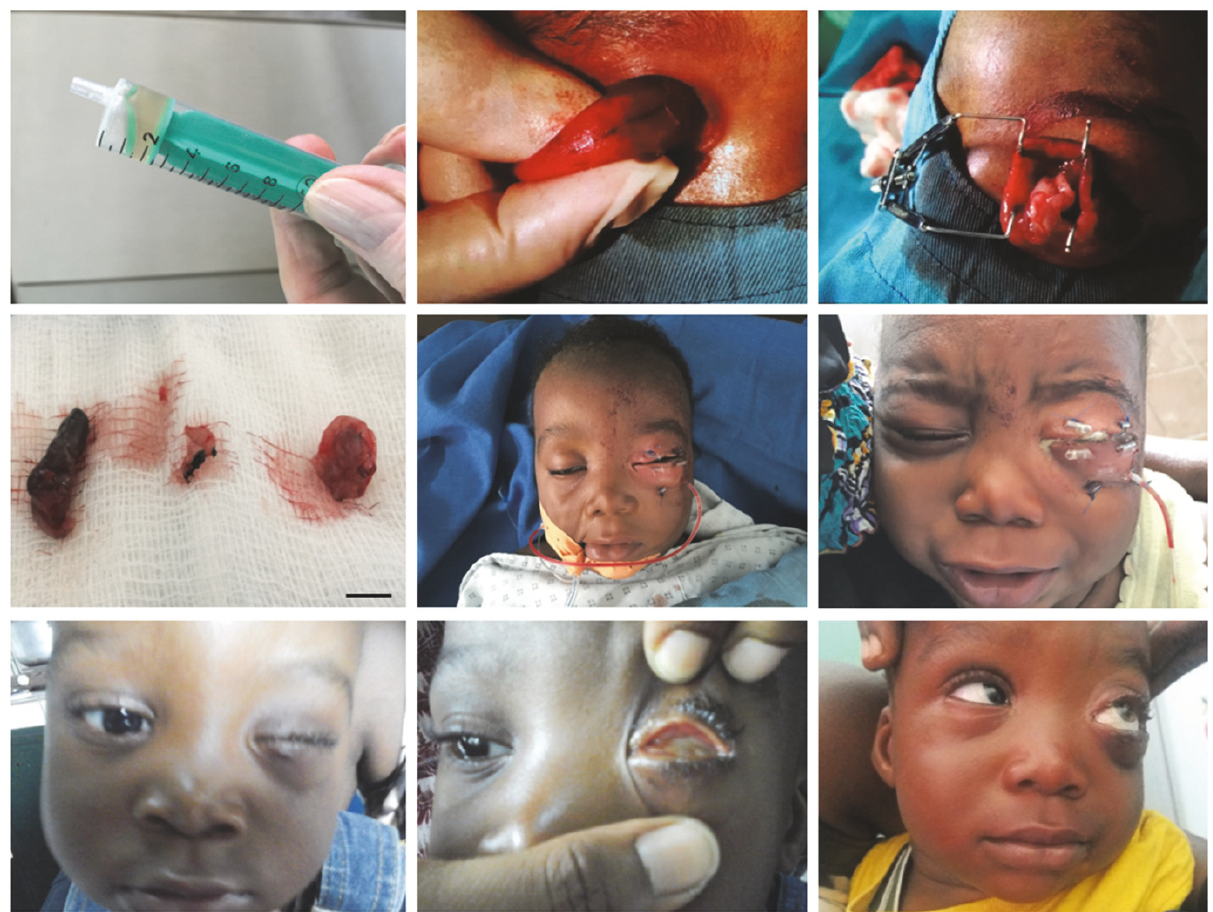
Figure 2: Intrasurgicalphotodocumentationand follow-up. A: drained cystic liquid; B: decompressed cyst; C: opened cyst; D: excised tissues; bar: 5 mm; E, F: transcutaneous fornix deepening sutures fixed over bolsters; G, H: 6 months’ follow-up; I: 8 months’ follow-up.